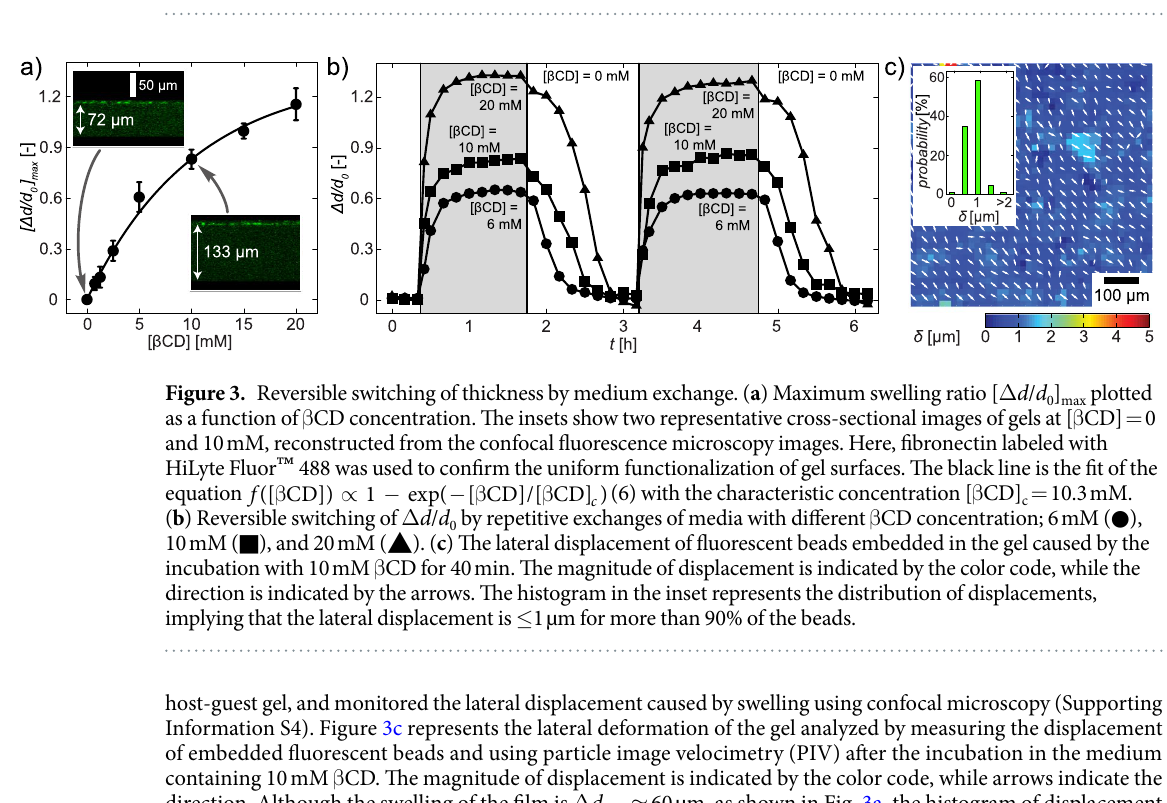
5 ScIentIfIc RepoRTS | 7: 7660 | DOI:10.1038/s41598-017-07934-x